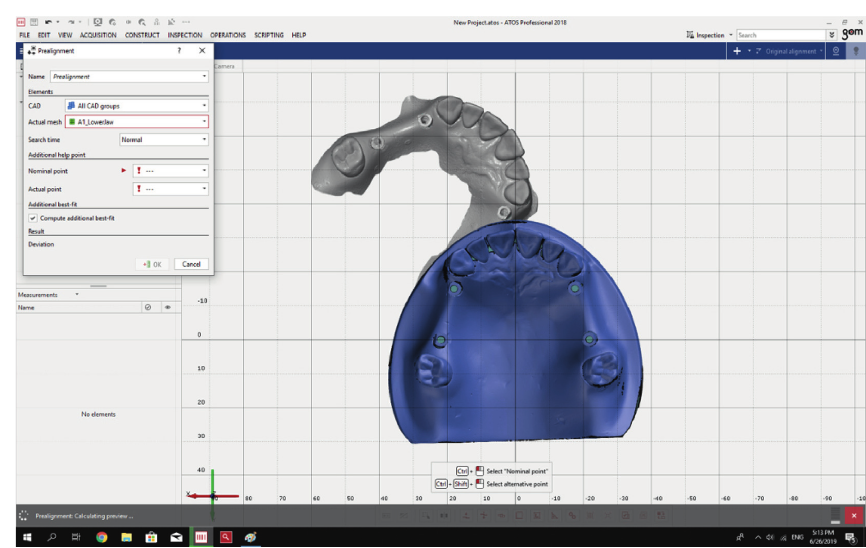
Figure 2: The prealignment feature was selected from the drop-down menu in the GOM Inspect